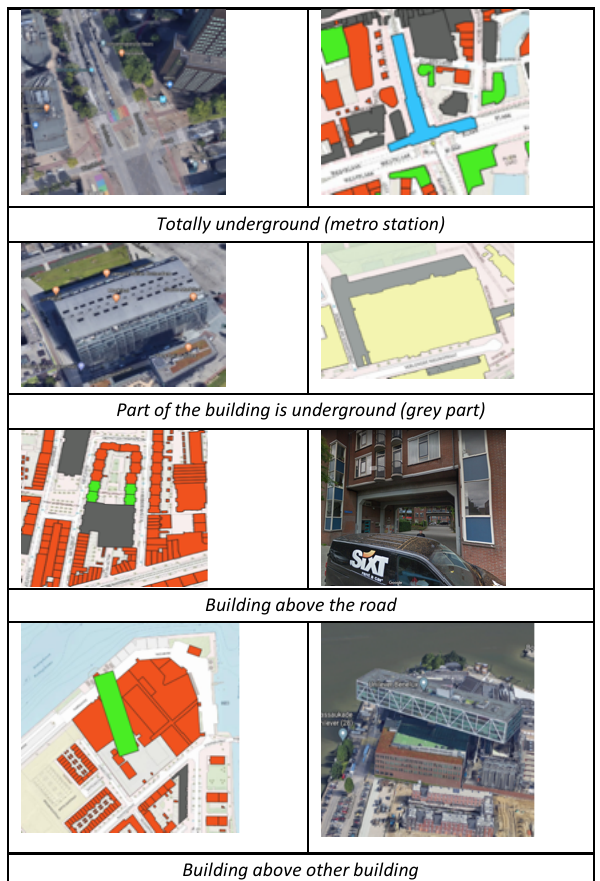
Figure 4: Examples of multi-level building